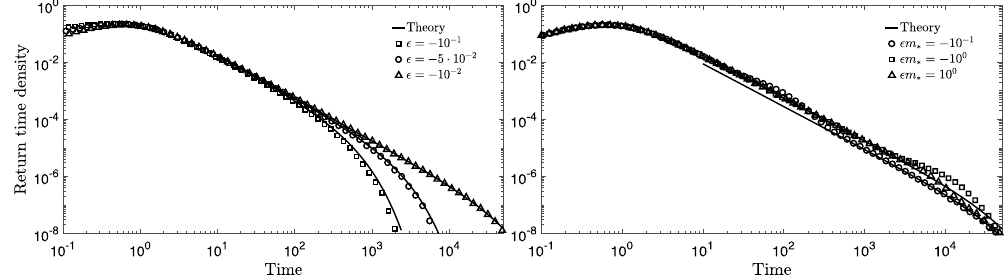
Figure 2. Comparison between theoretical prediction, eq. (5), and simulation results for the return time density to a given level. Simulated densities were constructed from 10 6 subsequent return time samples binned logarithmically using 100 bins. Theoretical fits are shown starting at t = 10 mean forcing frequencies. (A) Results for different values of ε < 0, with high return level m so that the lower boundary effect is negligible. * Results for the corresponding ε > 0 are similar. (B) Effect of the lower boundary; the two theoretical fits correspond to the cases ε  ⁎